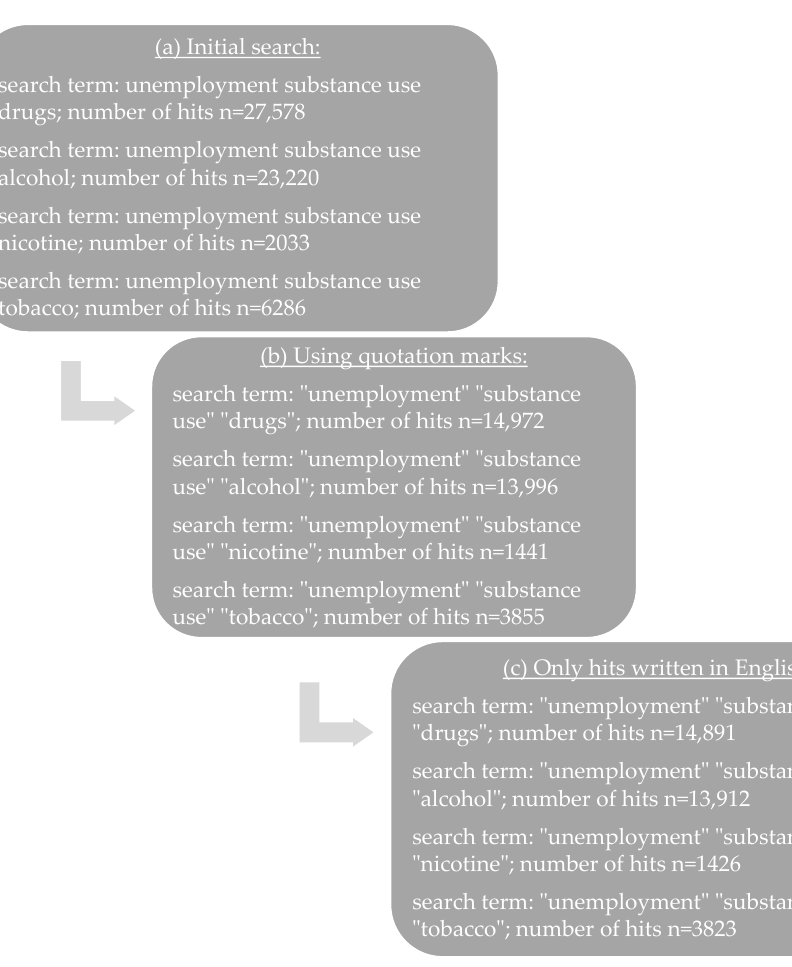
Figure 1. Search strategy and results of literature search between August 2010 and January 2023. ( a ) Initial search terms used, ( b ) quotations marks added, and ( c ) only texts written in English.